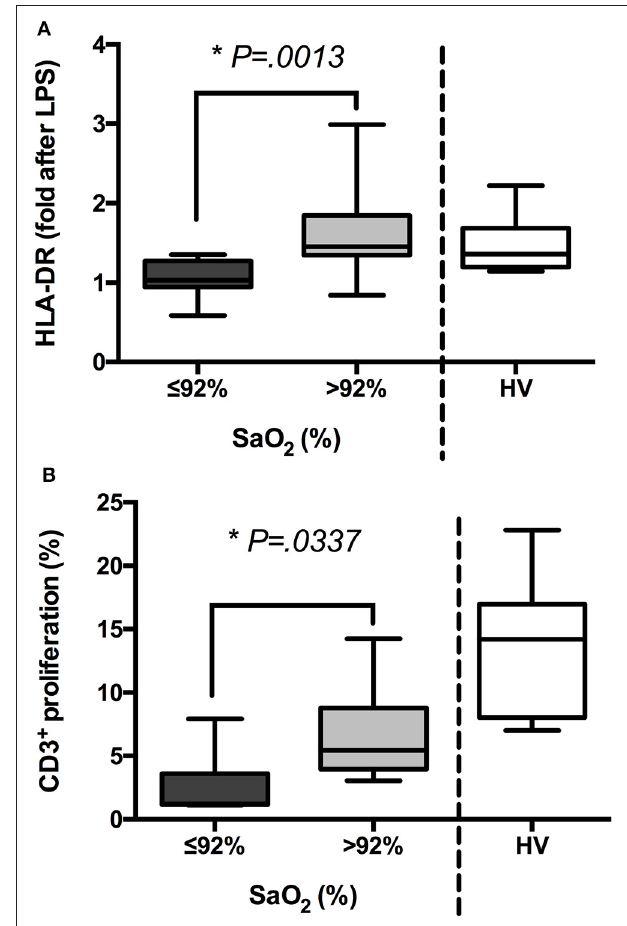
FIGURE 2 | The groups of patients with sepsis exhibit different states of activation after ex vivo challenge. (A) Blood samples from patients with sepsis ( n = 85) and healthy volunteers (HV, n = 15) were stimulated or not with LPS (5ng/mL, 3h) ex vivo . Then, mean intensity of fluorescence (MIF) of HLA-DR on the gate of CD14 + cells was analyzed by FACS. Folds after LPS challenge are shown in patients classified according to their oxygen saturation and HV. (B) PBMCs were isolated from patients with sepsis ( n = 85) and HV ( n = 15), labeled with CFSE and stimulated or not with PWD (2.5 µ g/mL) for 5 days. Then, proliferation of CD3 + cells was analyzed by FACS. Percentages of proliferation are shown in patients classified according to their oxygen saturation and HV * p < 0.05 using a Student’s t